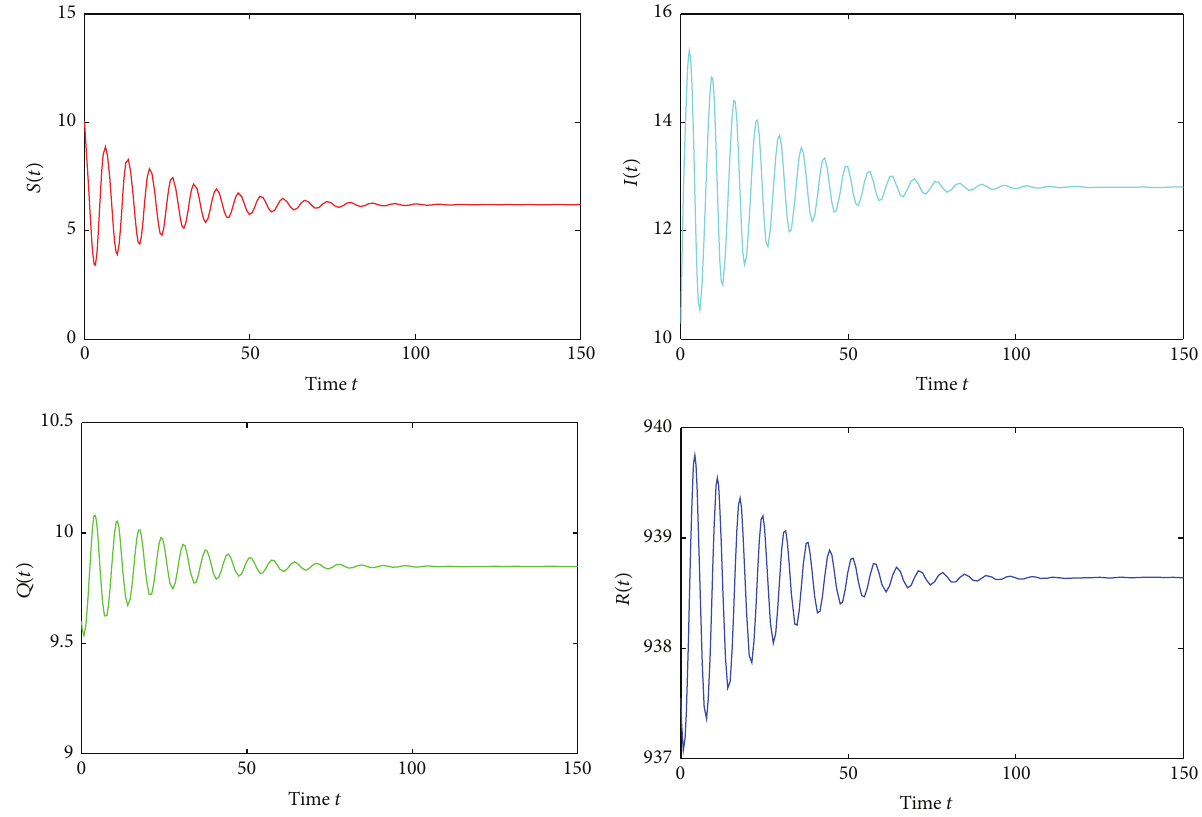
Figure 1: The track of the states 𝑆 , 𝐼 , 𝑄 , and 𝑅 for 𝜏 = 1.3025 < 1.3265 = 𝜏 0 .